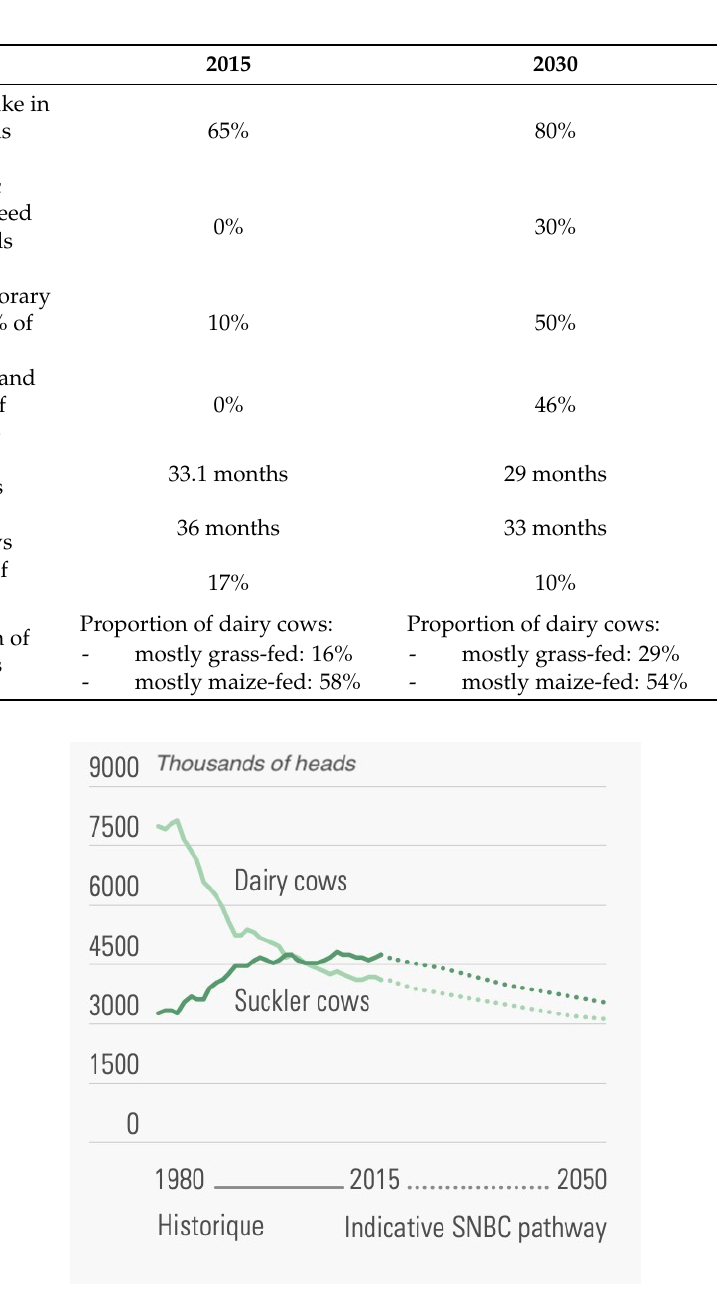
Figure 1. Evolution of the dairy and cattle herd as envisioned by SNBC with regard to the 1980–